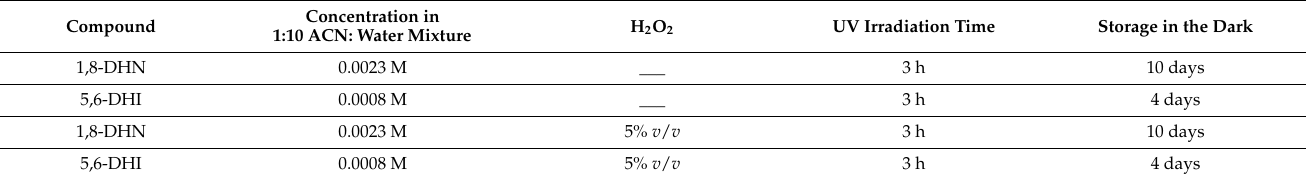
Table 1. Composition of samples, concentration, duration of UV exposure, and storage in the